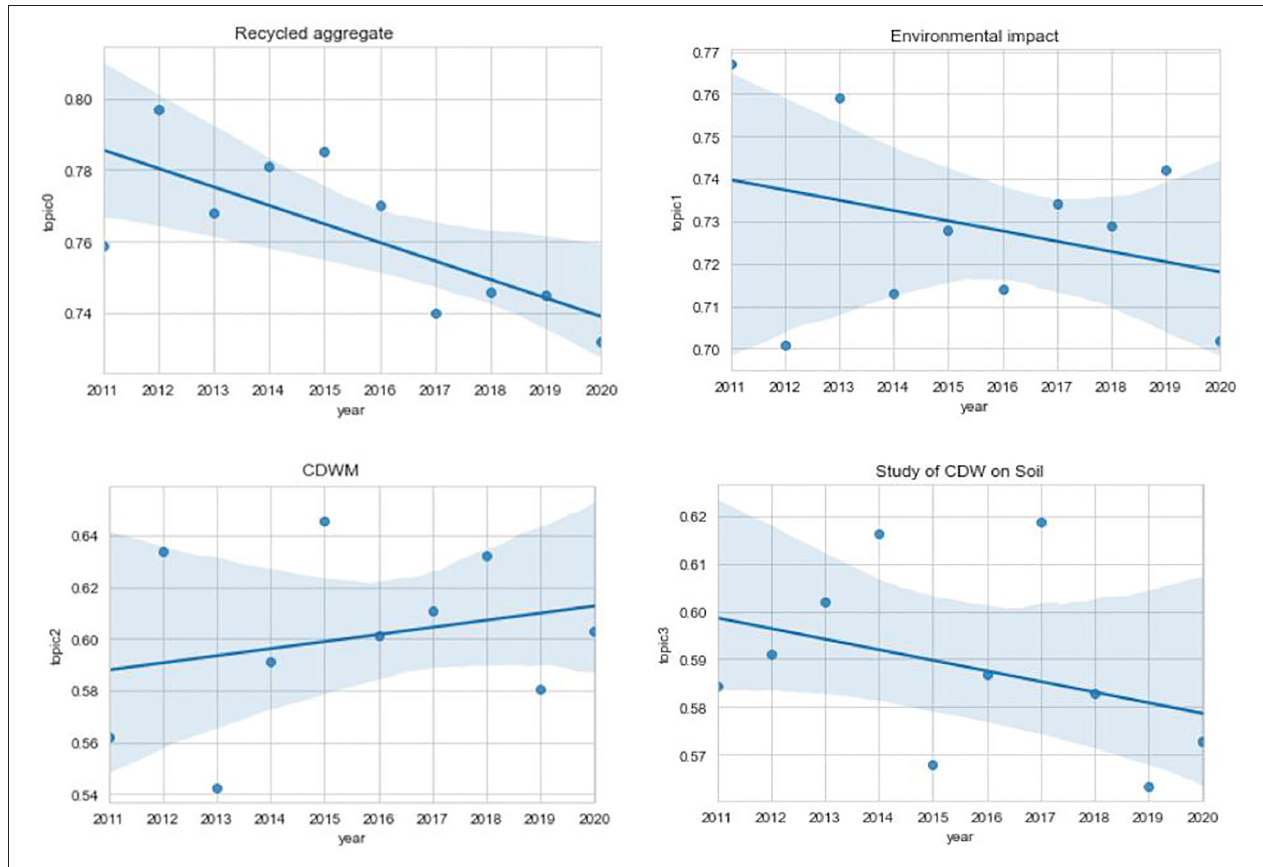
FIGURE 4 | Graph of the mean weight of articles by